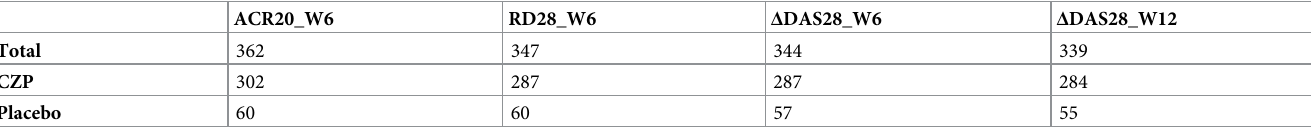
Table 2. Summary of data available for individual clinical outcome measures a